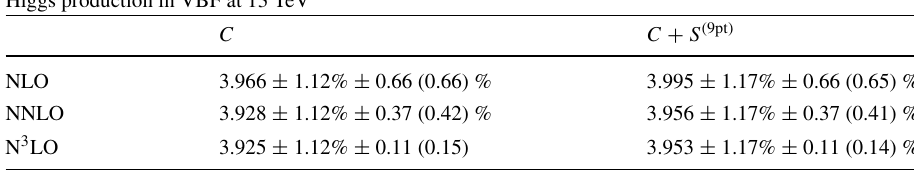
Higgs production in VBF at 13